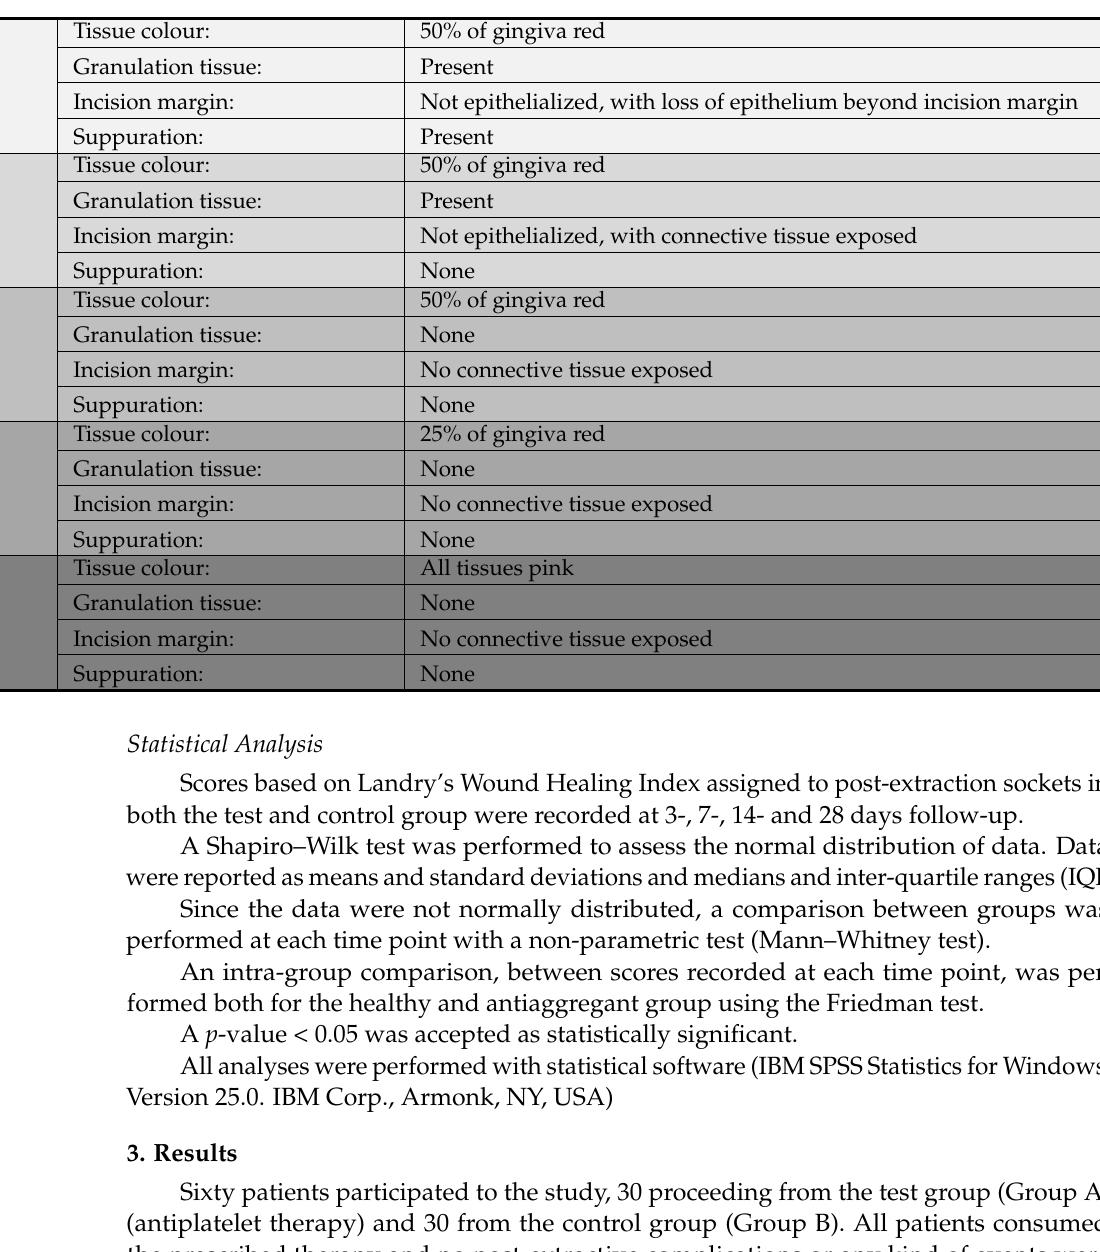
Table 2. Landry et al. [9]